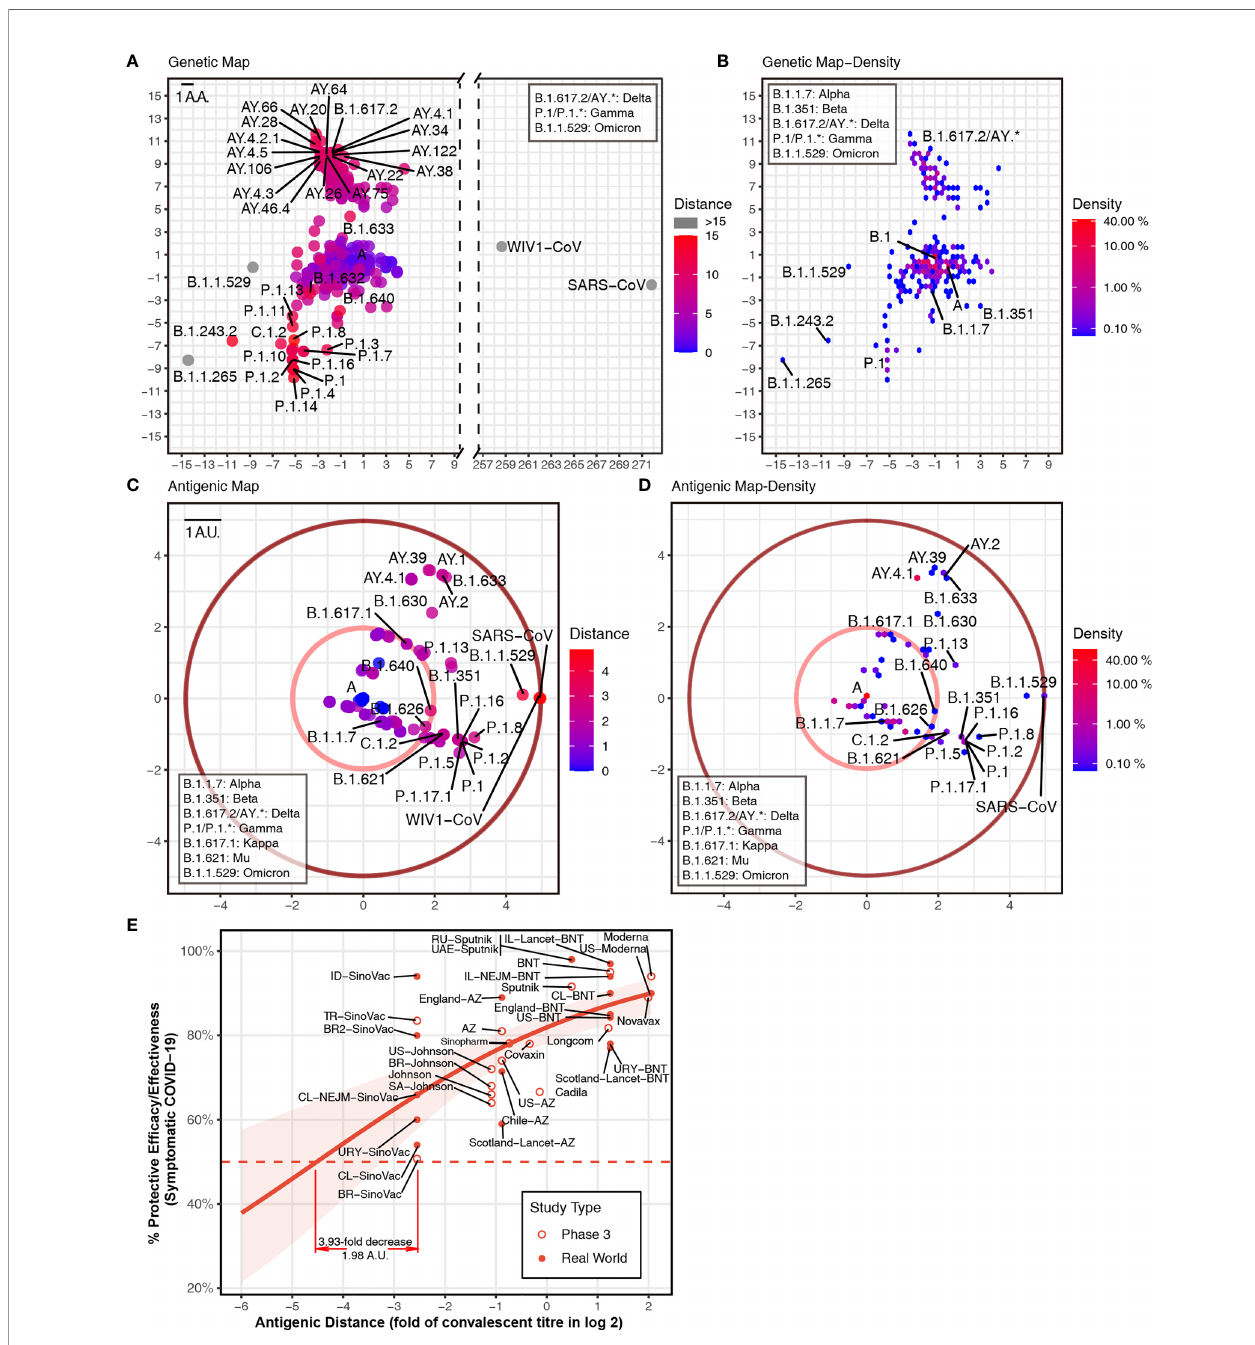
FIGURE 2 | Genetic and antigenic mapping of severe acute respiratory syndrome coronavirus 2 (SARS-CoV-2) variants. (A) Genetic map of SARS-CoV-2 variant strains shows amino acid mutation numbers of spike proteins, and (B) the density of genetic map shows the distribution of the variants. The vertical and horizontal axes represent the measured relative genetic distances (1 amino acid/1 AA = 1 amino acid difference). (C) Antigenic map of SARS-CoV-2 variant strains shows the antigenic distance between variants, and (D) the density of antigenic map shows the distribution of the variants. Variants outside the pink circle are vaccine breakthrough candidates. The red circle suggested the border of antigenic map. The antigenic distance is based on receptor-binding domain (RBD) amino acid sequences. The vertical and horizontal axes represent the measured relative antigenic distances (1 arbitrary unit/1 AU = 1-fold decrease in the neutralization titer on a log 2 scale). Colors show the antigenic distance to the SARS-CoV-2 original strain (lineage A). (E) Relationship between antigenic distance (mean of neutralization titers in vaccinees divided by corresponding mean of titers in convalescent patients in log 2) and protection from SARS-CoV-2 infection. The reported mean neutralization level from phase 1 or 2 studies ( Table S4 ) and the protective ef fi cacy or effectiveness from phase 3 trials or real-world studies ( Table S5 ) for different vaccines. The red line indicates the logistic model, and the red shading indicates the 95% con fi dence interval of the model. Here, we mark the basis of setting up the cutoff of 3.93-fold decrease (1.98